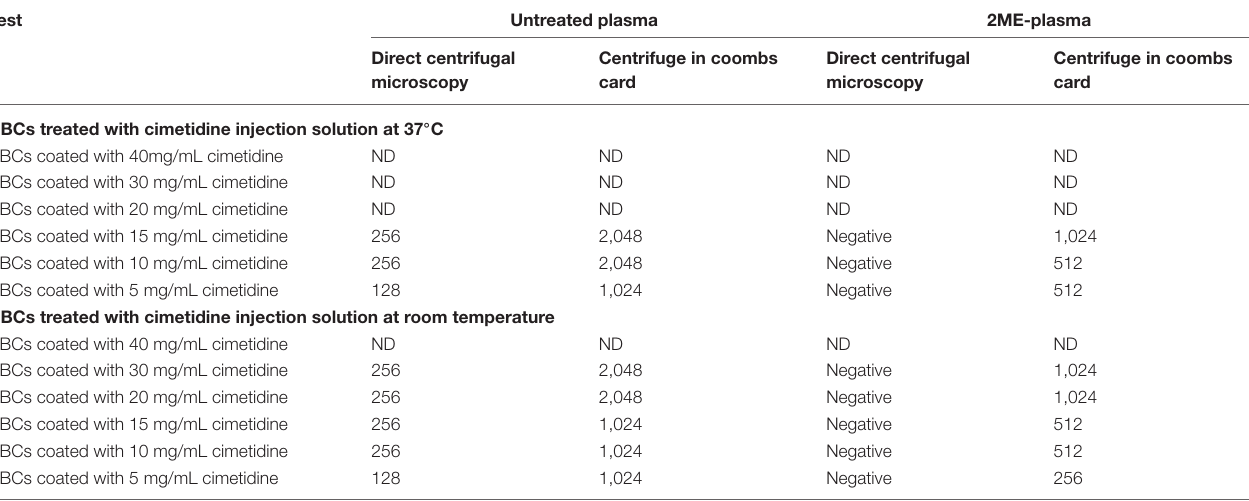
TABLE 4 | Results of cimetidine-dependent antibodies titers detection with cimetidine-coated RBCs for the sample collected at 6 days after the patient oral administration of diclofenac sodium and